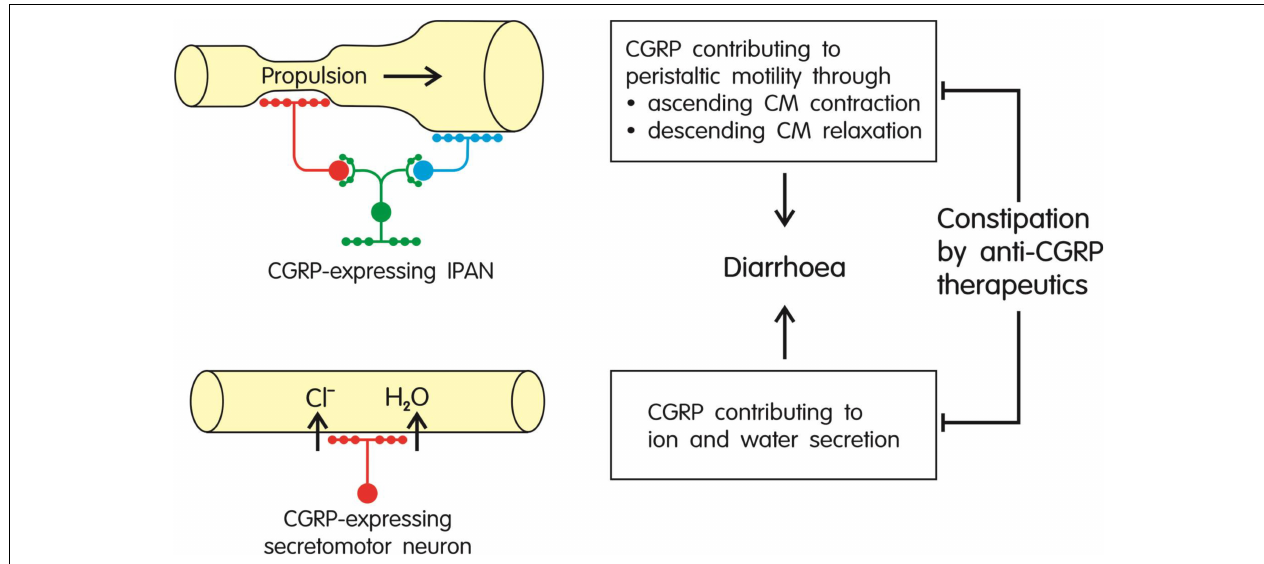
FIGURE 3 | Summary of the major effects of CGRP in the gut: stimulation of peristaltic motor activity and increased secretion of ions (primarily Cl - ) and water, both effects in combination causing diarrhea. As these effects of the peptide are likely to contribute to the maintenance of propulsive motility, ion and water homeostasis and intestinal transit, inhibition of CGRP signaling by anti-CGRP migraine therapeutics is expected to cause constipation. CM, circular muscle; IPAN, intrinsic primary afferent